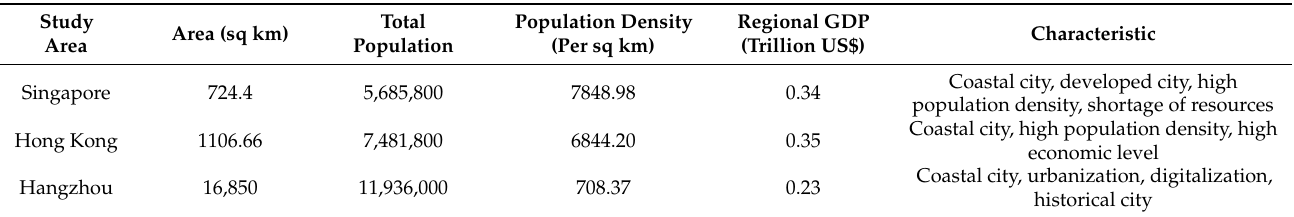
Table 4. A general comparison of the three Asian